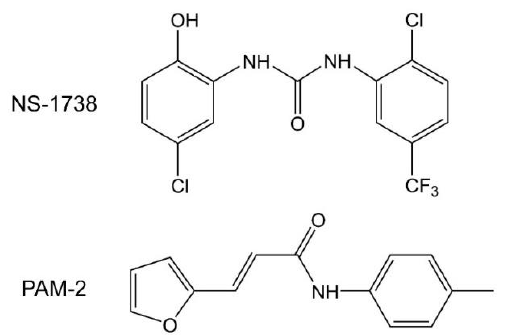
Figure 1. Structural formulas of N -(5-Cl-2-hydroxyphenyl)- N ’-[2-Cl-5-(trifluoromethyl)phenyl]-urea (NS-1738) and ( E )-3-(furan-2-yl)- N -( p -tolyl)-acrylamide (PAM-2).